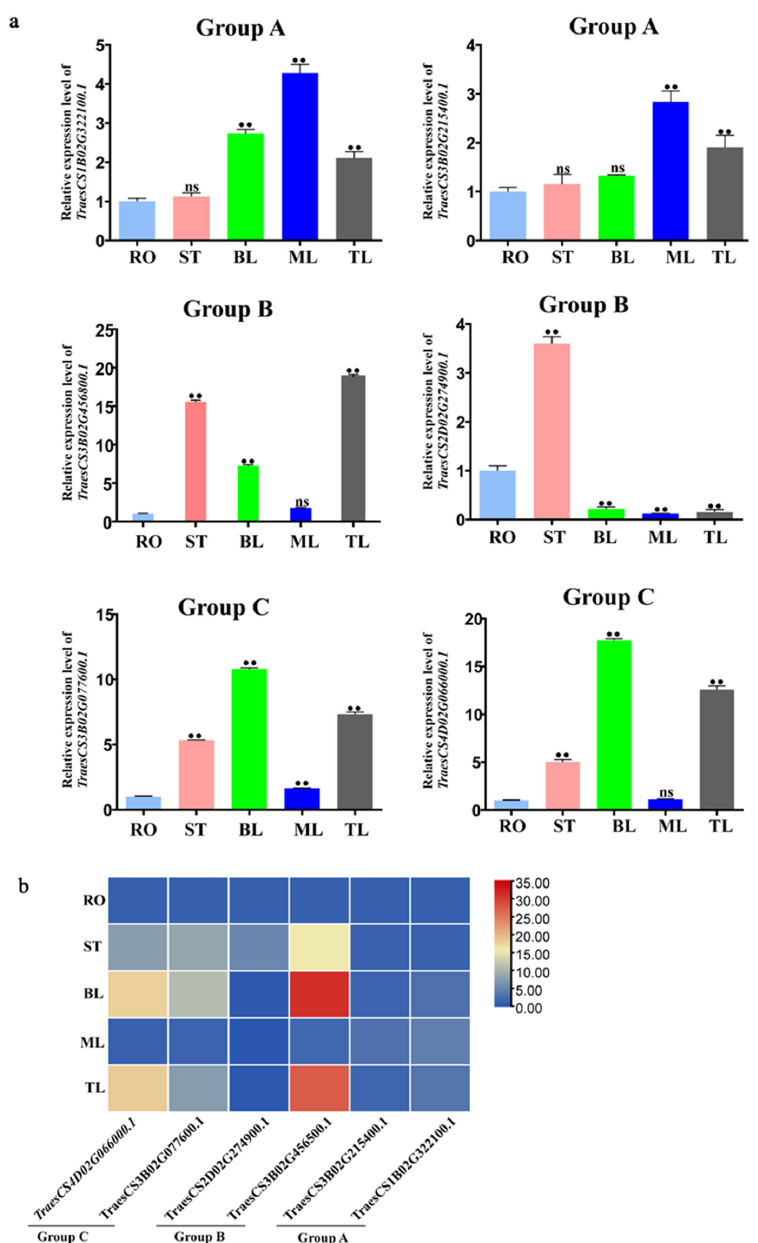
Figure 9. Expression pattern analysis of selected TaCystatin genes among different organs. ( a ) Raw data indicating the relative expression levels of selected TaCystatin genes in distinct organs. Means ± standard deviations (SE) were deciphered from three biological replicates and each biological replicate had three technical replicates. Note: ns, not significant and **, p < 0.01 (Student’s t -test). ( b ) Heatmap indicating the relative expression of the selected TaCystatin genes in distinct organs. Color scale represents relative expression values, with the color from blue to red indicating low to high expression abundance. Abbreviations: RO, roots; ST, stem; BL, bottom leaf; ML, middle leaf; and TL, top leaf. The expression of RO was regarded as the